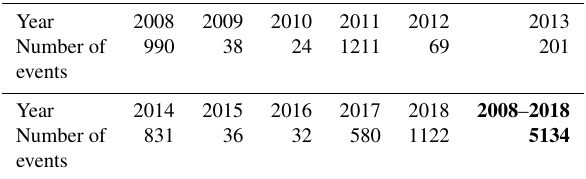
Table 3. Number of reported events for each year. Bold numbers represent the total